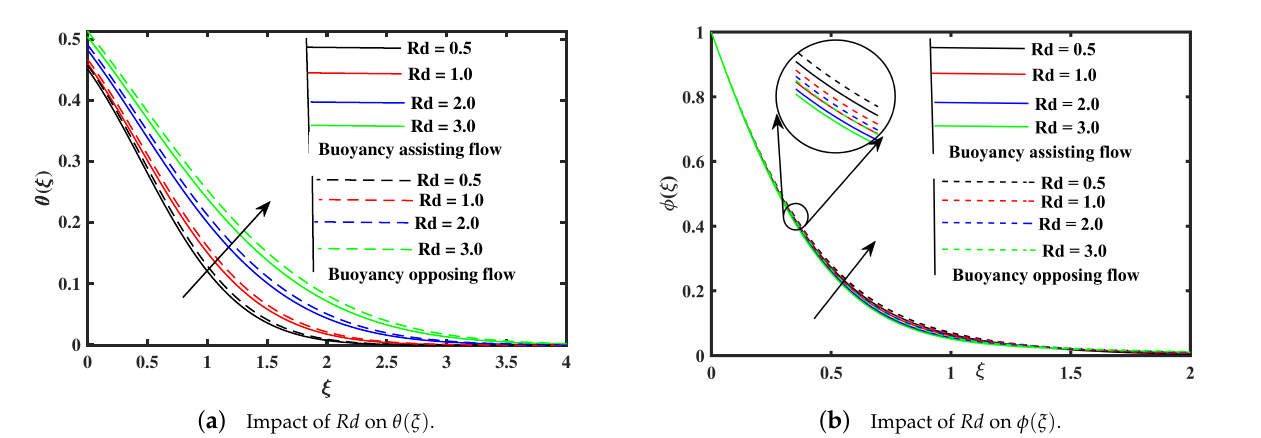
Figure 11. Fluctuation of θ ( ξ ) and φ ( ξ ) against radiation ( Rd ).